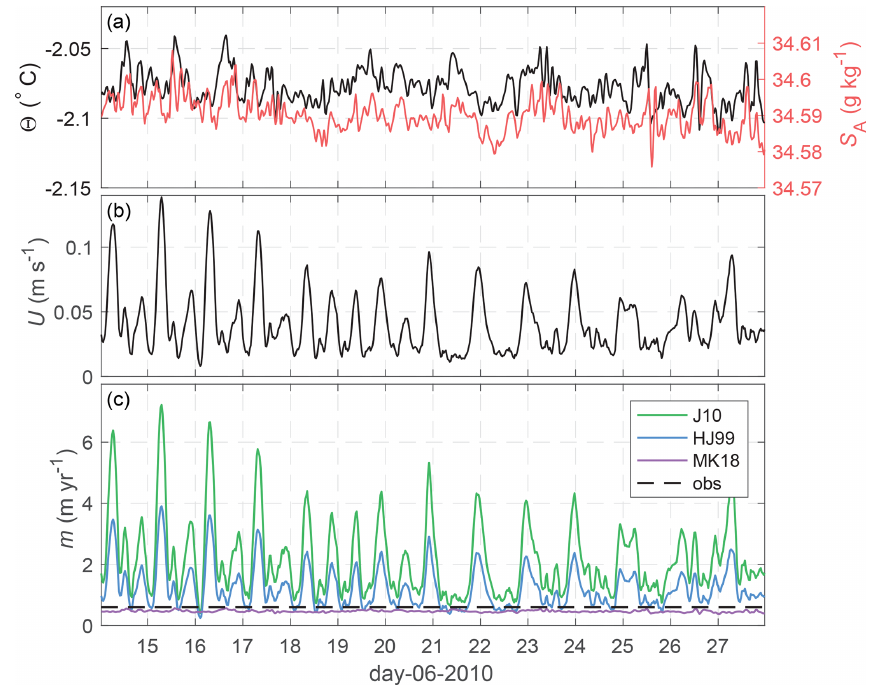
Figure 9. (a) (cid:50) and S A from the upper MicroCAT 4m below the ice, (b) current speed depth-averaged over 7–19m below the ice base, and (c) parameterised melt rates for the three parameterisations compared in this study. While the J10 and HJ99 melt rates are strongly modulated by the tidal currents at AM06, MK18 varies only with